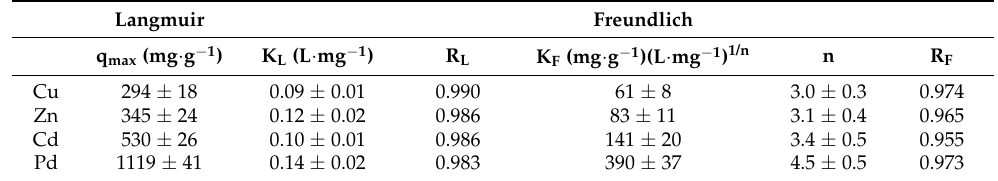
Table 3. Parameters for Langmuir and Freundlich models of Cu(II), Zn(II), Cd(II), and Pb(II) sorption on GO [69] (Adapted with permission from ref. [69]. Copyright 2013 RCS